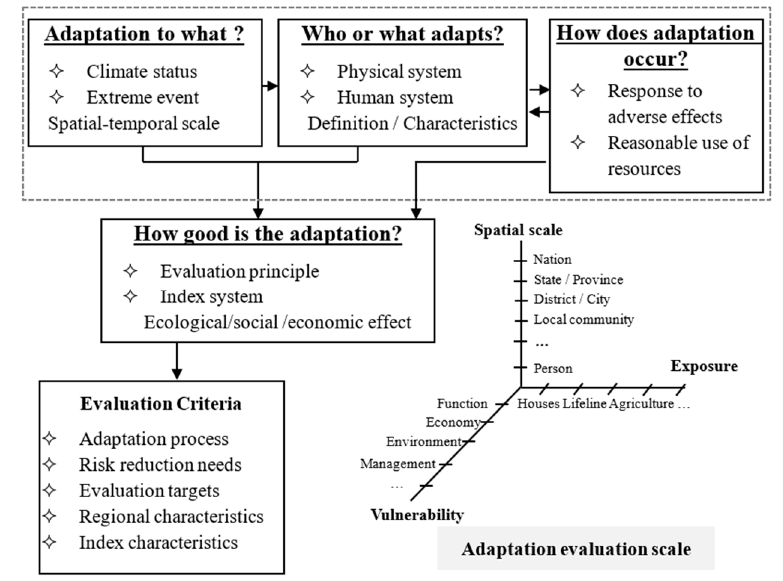
Figure 4. Adaptability constitutes and evaluation framework.